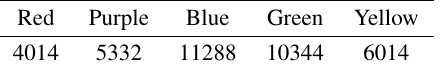
Figure 8. Visibility analysis considering several agents. Top image - observed voxels represented through a heat map; bottom image - extended heat map in Z direction. more voxels covered fewer times (i.e., yellow + green voxels) than voxels that are observed many times (i.e., purple + red voxels), making the observing process by the agents unevenly distributed within the AoI.